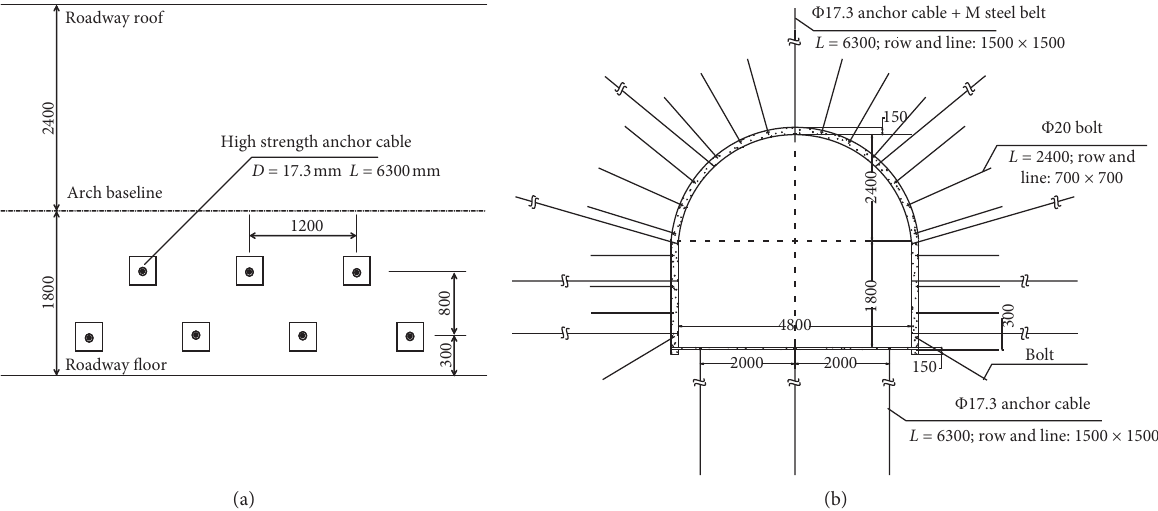
Figure 13: Reinforcement supporting scheme of 101 track roadway (unit: mm).